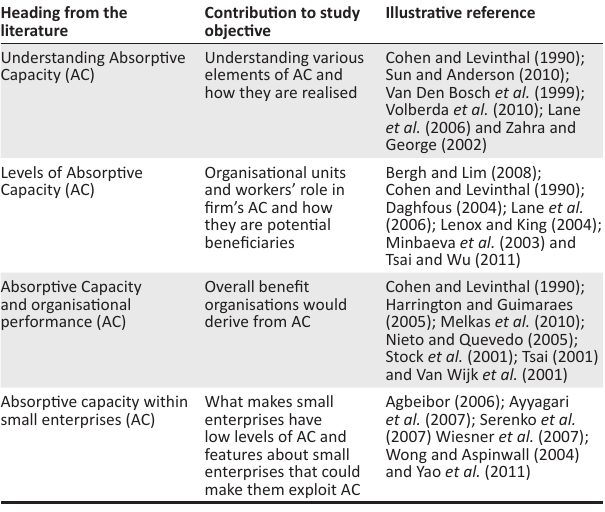
TABLE 8: How the literature study addressed the research question